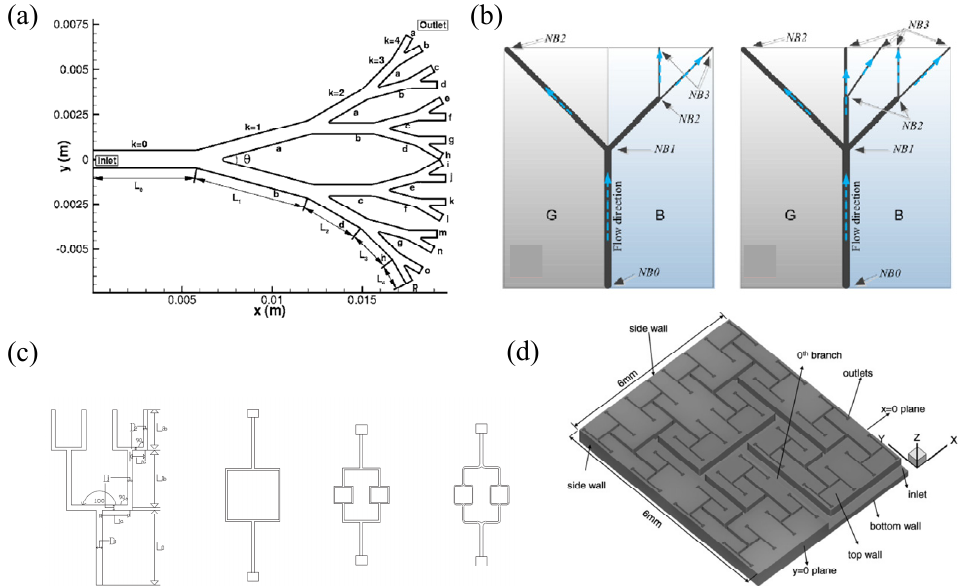
Figure 14. Geometry optimization of fractal microchannel: ( a ) Wang et al. (adapted from Ref. [105]), ( b ) Rubio-Jimenez et al. (adapted from Ref. [106]), ( c ) Zhang et al. (adapted from Ref. [107]), ( d ) Hong et al. (adapted from Ref. [108]).